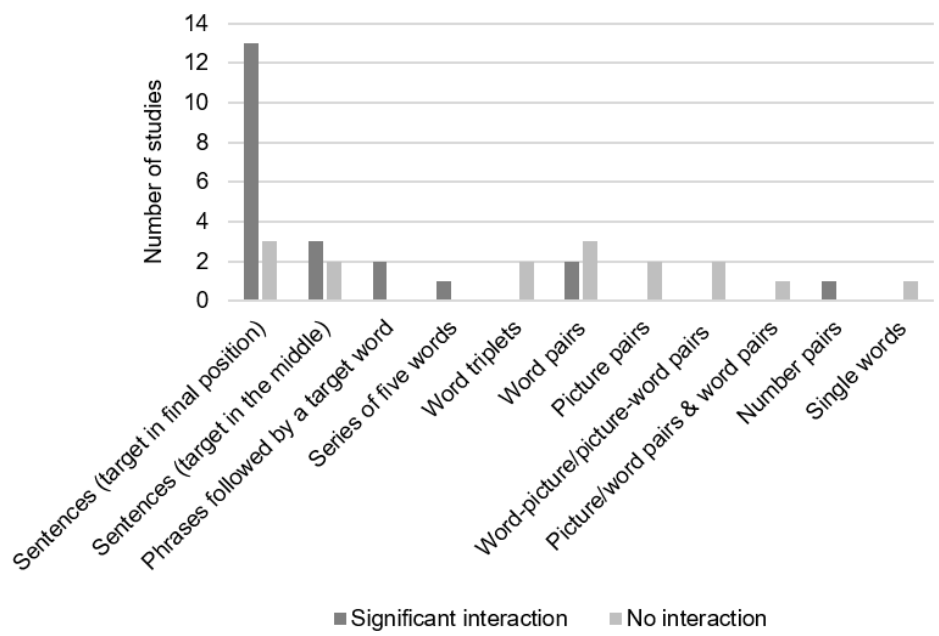
Figure 6. Number of studies that found a significant interaction between age and semantic association for the N400 amplitude as a function of stimulus type.